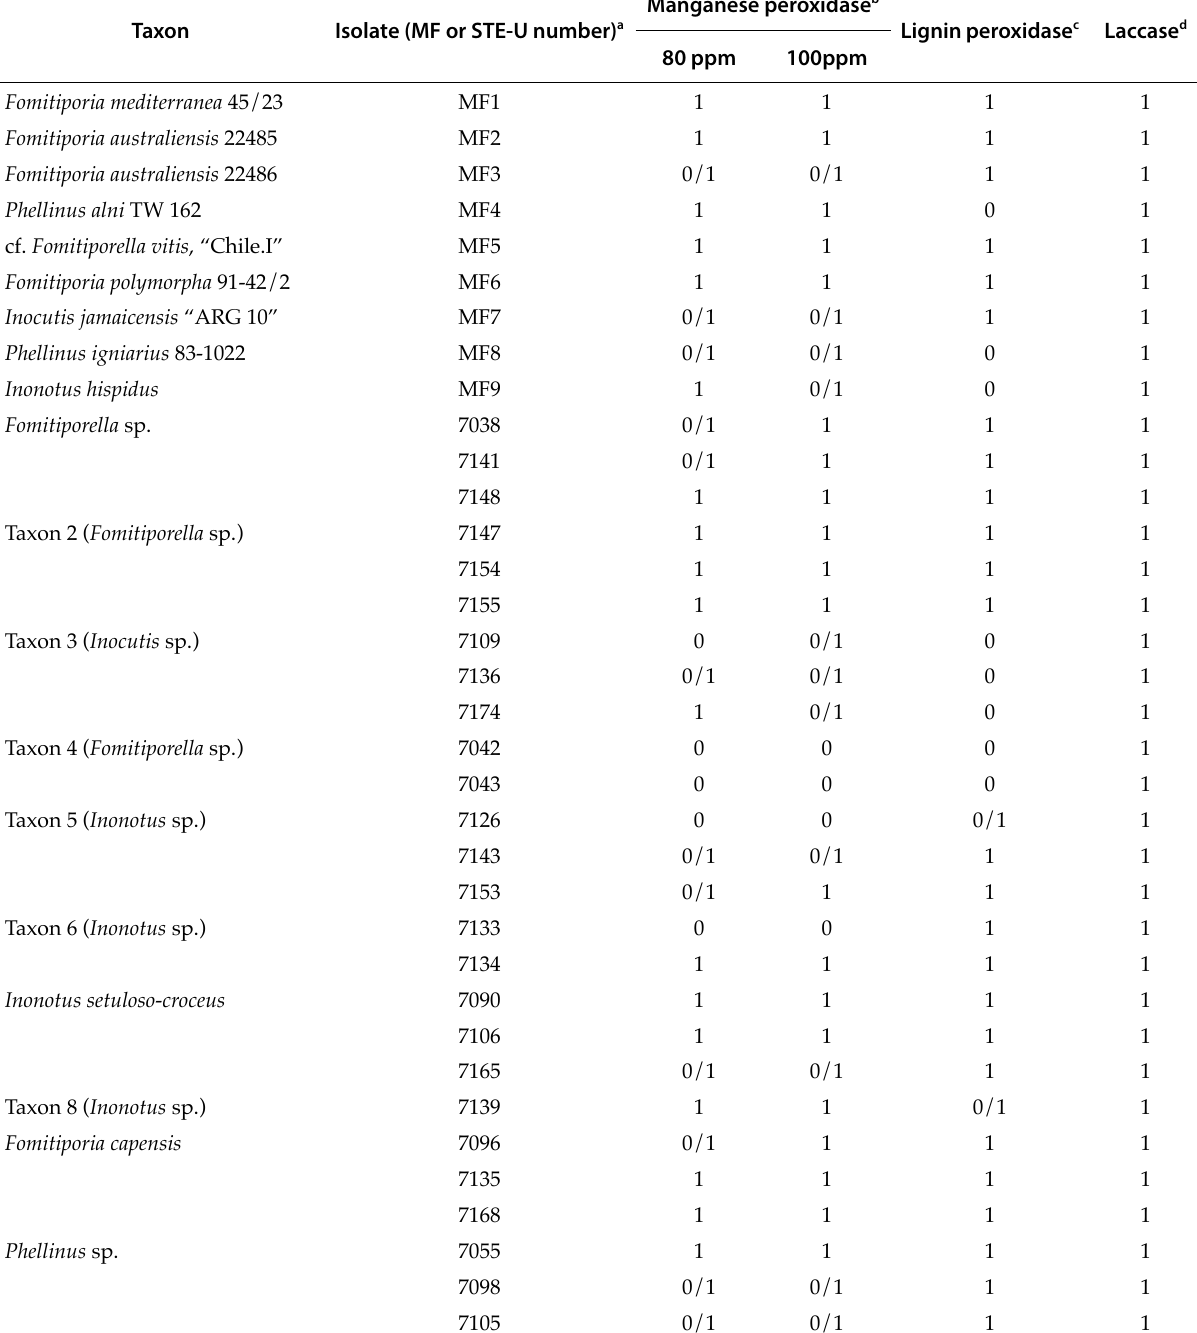
Table 2. The results of assays testing for manganese peroxidase, lignin peroxidase and laccase activity on Hymenochaetales isolates from White et al. (2011a) as well as reference isolates.